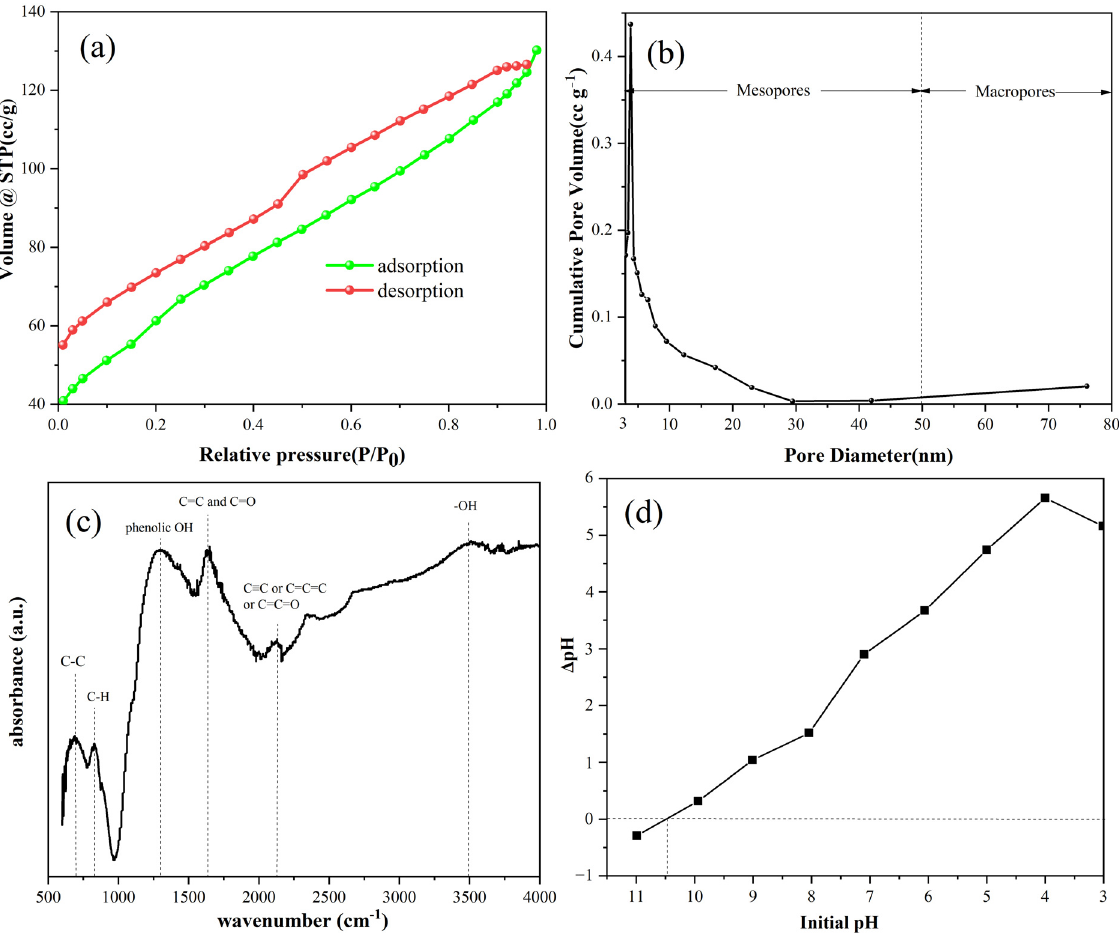
Figure 6. Characterization of NZVIs-BC: ( a ) adsorption and desorption isotherm; ( b ) pore size distribution; ( c ) fourier transform infrared spectroscopy; ( d ) point of zero charges. Table 3. The isothermal nitrogen adsorption–desorption report of NZVIs-BC (FS:RS = 1:5).